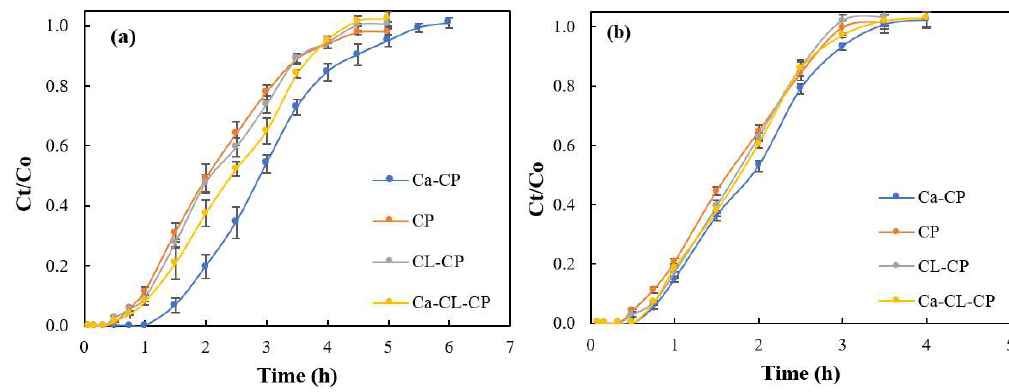
Figure 4. Breakthrough curves for the adsorption of sulfate by the various adsorbent systems: ( a ) pH 4.5, and ( b ) pH 6.5 (initial sulfate concentration = 1000 mg/L, 25 °C, flow rate of 3 mL/min, and bed height = 200 mm). Table 1. Breakthrough curve parameters for variable adsorbents for the adsorption of SO 2 −